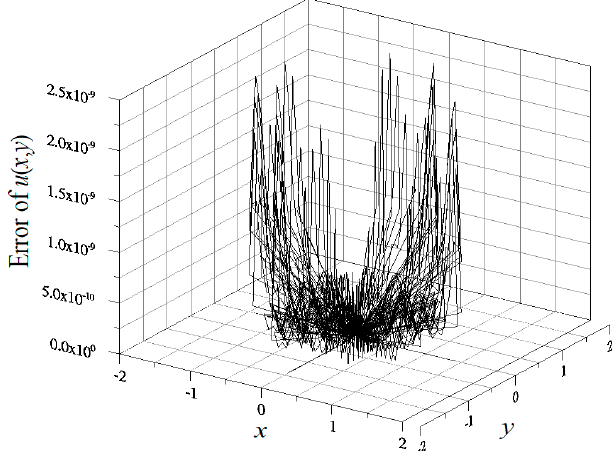
Figure 14. The exact solutions for the steady-state AC equation with Cassini-shaped domain are shown in ( a ), and in ( b ) the proposed approach solution without random noise.